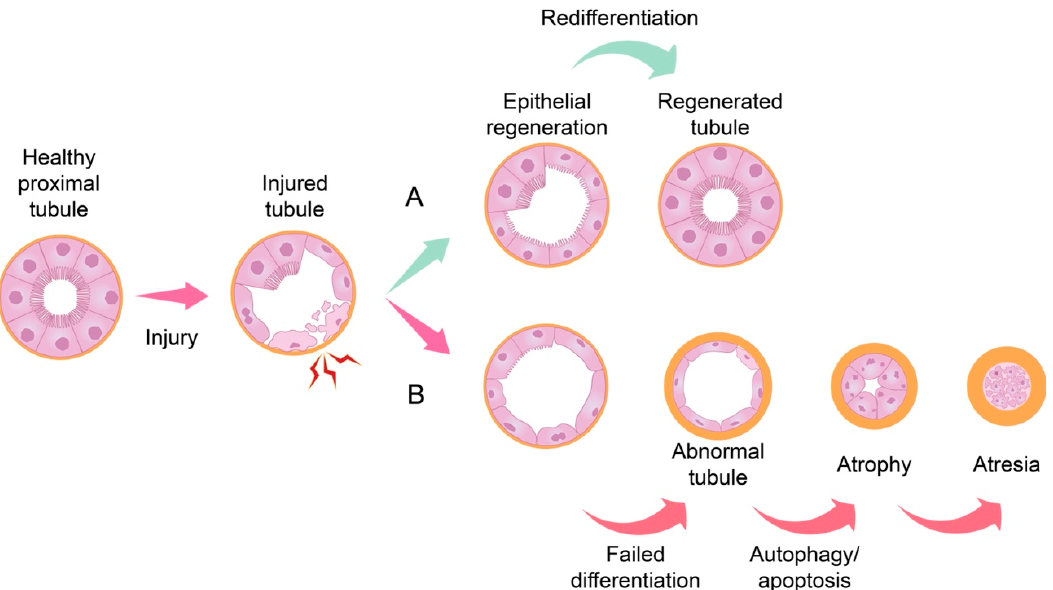
Figure 1. Schematic representation of renal tubule repair after injury. After initial tubular injury, remaining healthy tubular epithelial cells undergo dedifferentiation and proliferate to repair damaged tubules. ( A ) Normal repair can result in full restoration of tubular epithelial structure and function. However, ( B ) continuous injury or impaired differentiation may lead to abnormal tubules, thickening of the basement membrane and subsequently to autophagy and apoptosis. Defective regeneration and repair will eventually result in the development of chronic inflammation and fibrosis leading to chronic kidney disease.